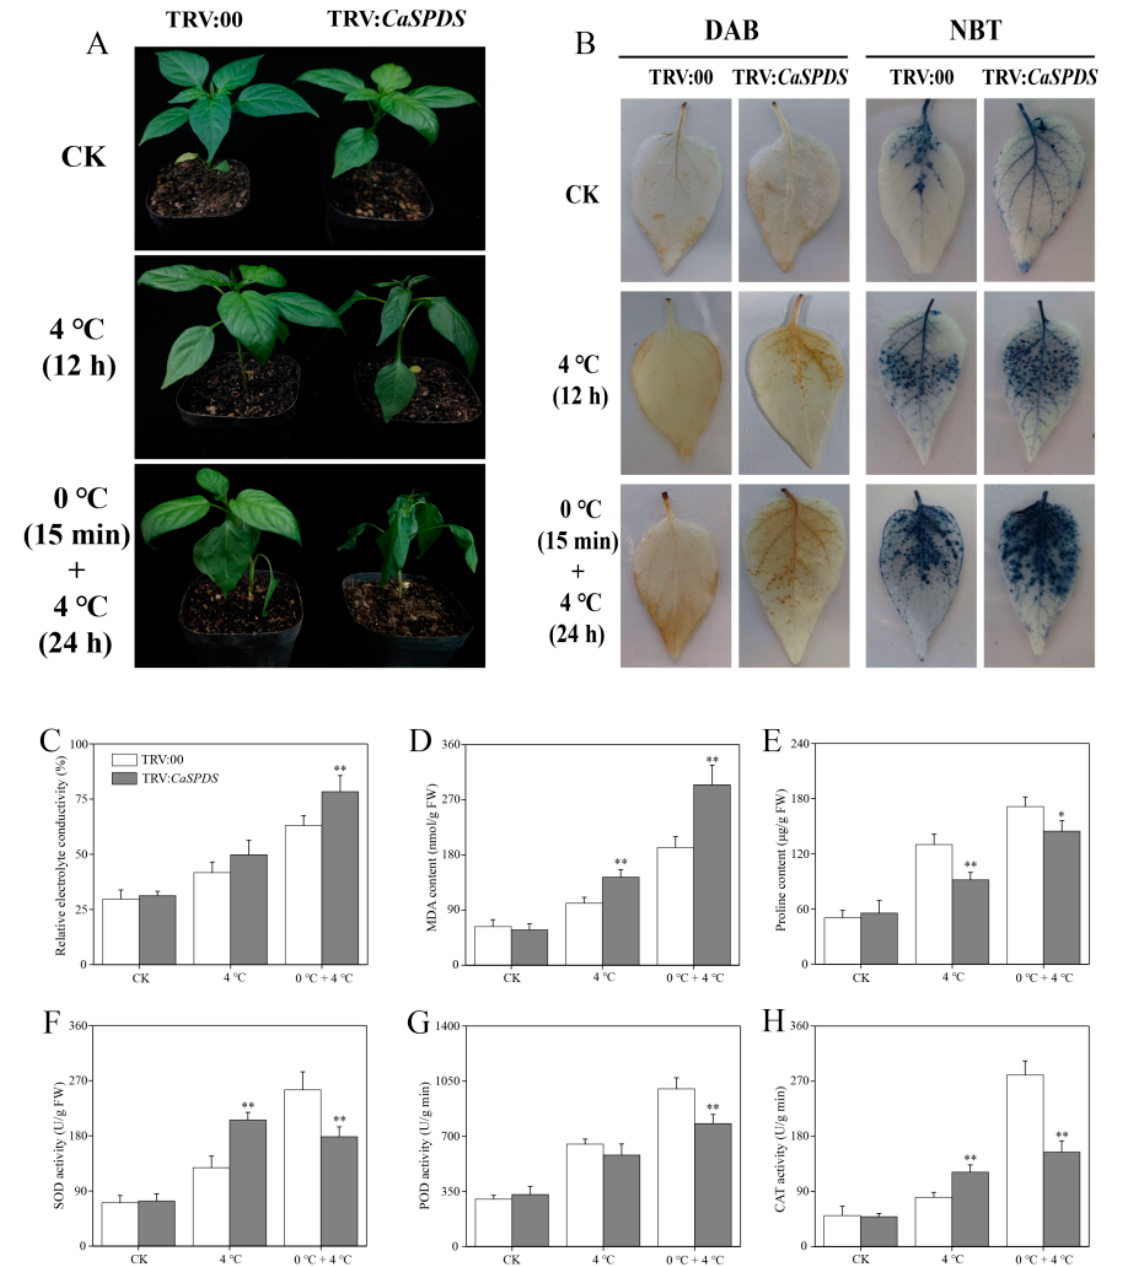
Figure 5. Effect of CaSPDS silencing on pepper tolerance to cold stress. ( A ) Phenotype, ( B ) tissue staining, ( C ) relative electrolytic leakage, ( D ) MDA content, ( E ) proline content, ( F ) SOD activity, ( G ) POD activity, and ( H ) CAT activity of TRV:00 and TRV: CaSPDS plants after cold treatment. “*” represents p < 0.05, and “**” represents p < 0.01 between WT and transgenic lines. 2.6. CaSPDS-Overexpressing (CaSPDS-OE)